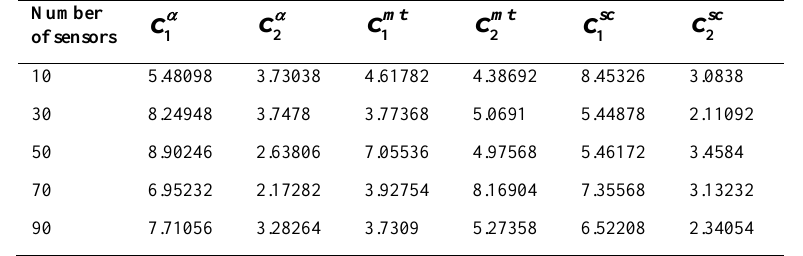
Table 1. Optimal forces of Single-COM flocking control for different sizes found by GSA for various numbers of sensors. Number of